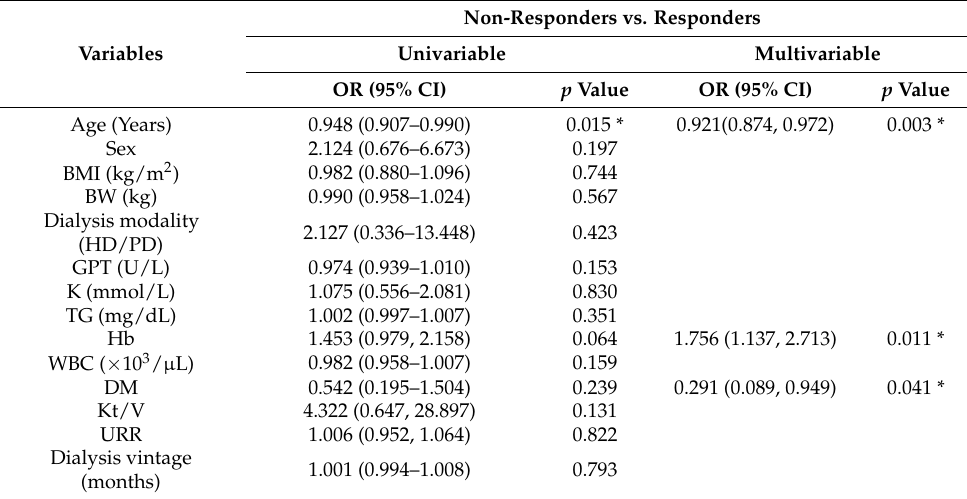
Table 2. Clinical factors associated with poor immunogenicity of dialysis patients.